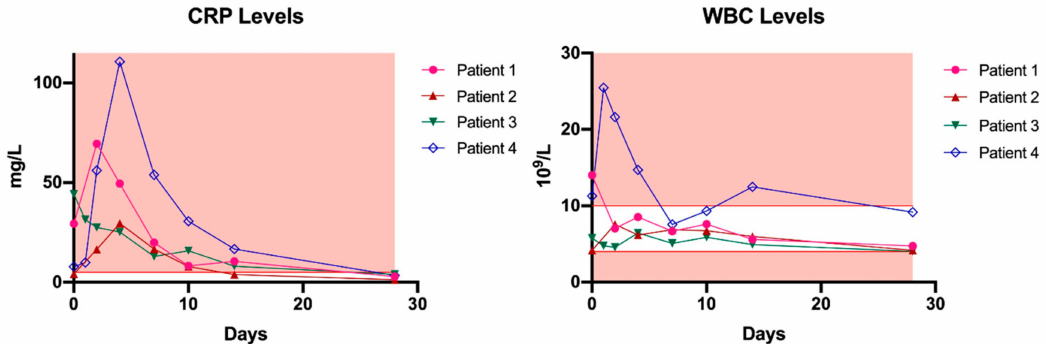
Figure 1. C-reactive protein (CRP) and white blood cell (WBC) levels in patients treated with phage therapy. The red background represents all values outside the reference range. Day 0 represents the baseline measurement, before phage therapy. Reference values: CRP: ≤ 5 mg / L, WBC: (4–10) × 10 9 /